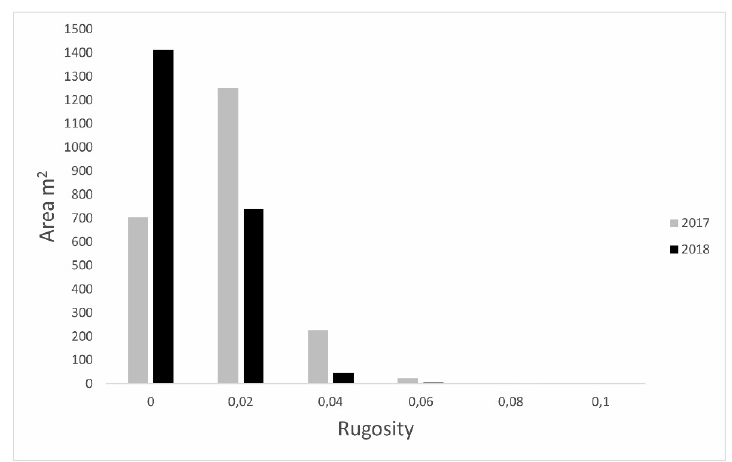
Figure 9. The histogram describes the temporal change (from 2017 to 2018) in the extent of areas with the same rugosity index in the selected portion of Area 2 (Figure 8). the same rugosity index in the selected portion of Area 2 (Figure